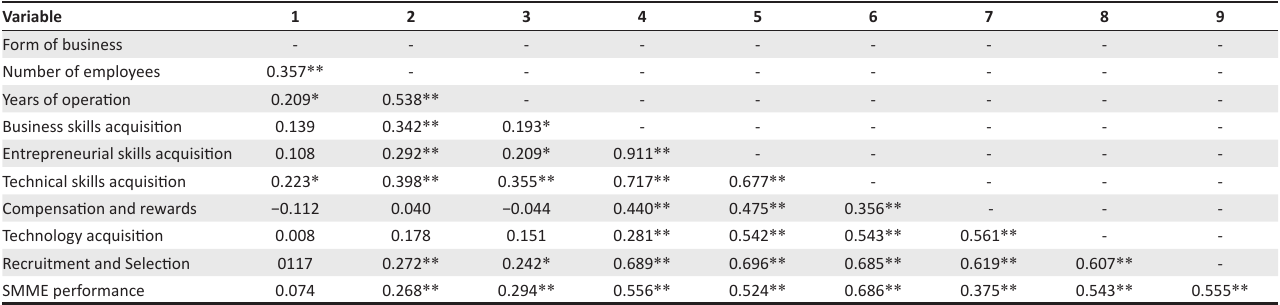
TABLE 3: Intercorrelations amongst study variable.